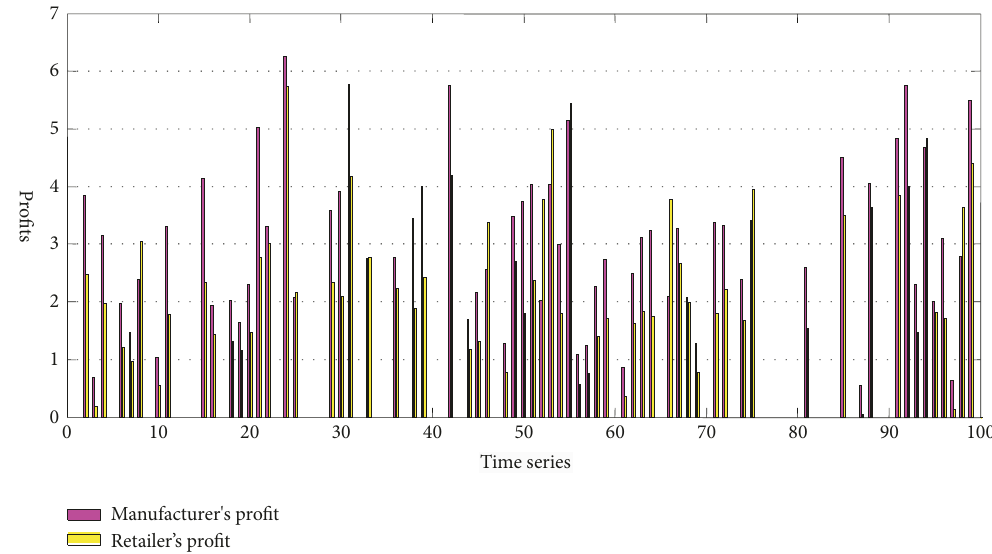
Figure 8: Profits of manufacturer and retailer.